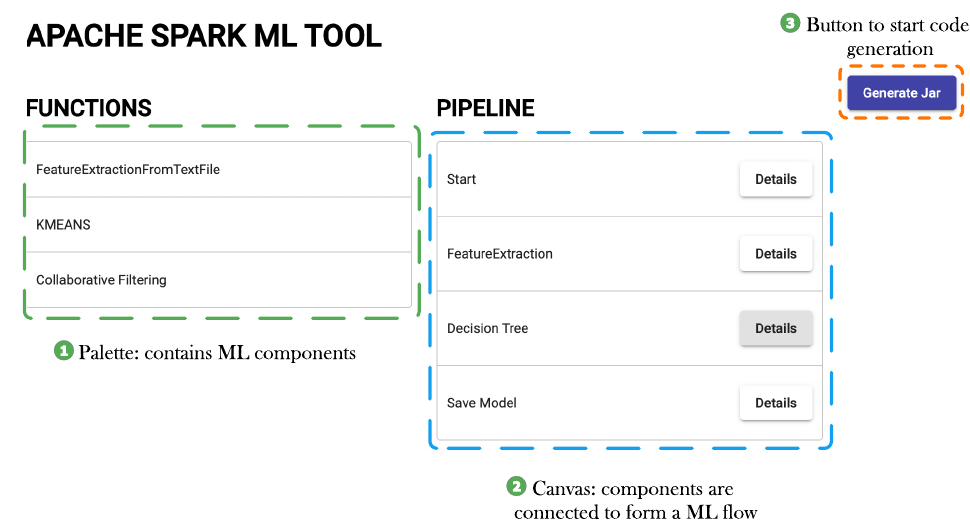
Figure 4. Interactive GUI of the prototype with palette and canvas.